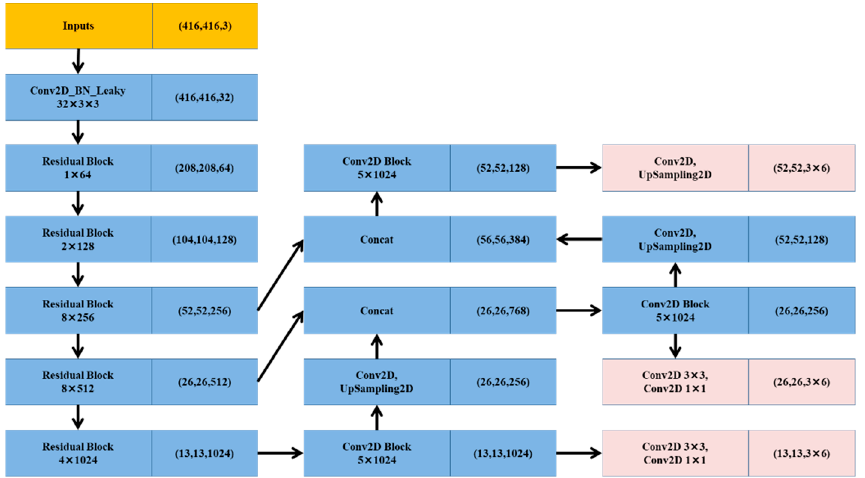
Figure 5. Structure of YOLOv3.